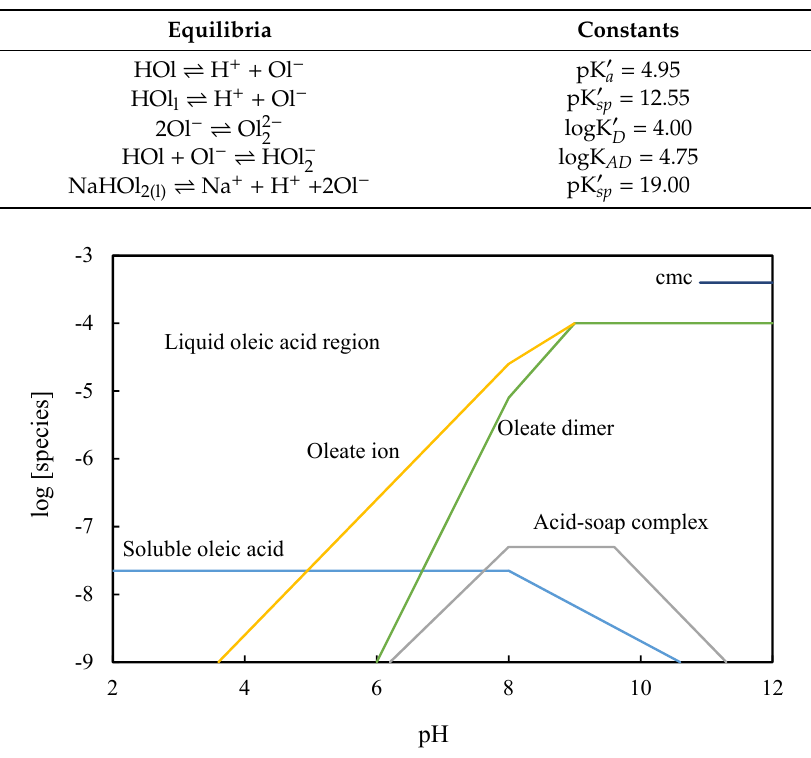
Figure 1. Species distribution diagram of oleate as a function of pH (total concentration = 1 × 10 − 2 mol / L) (after [29]).